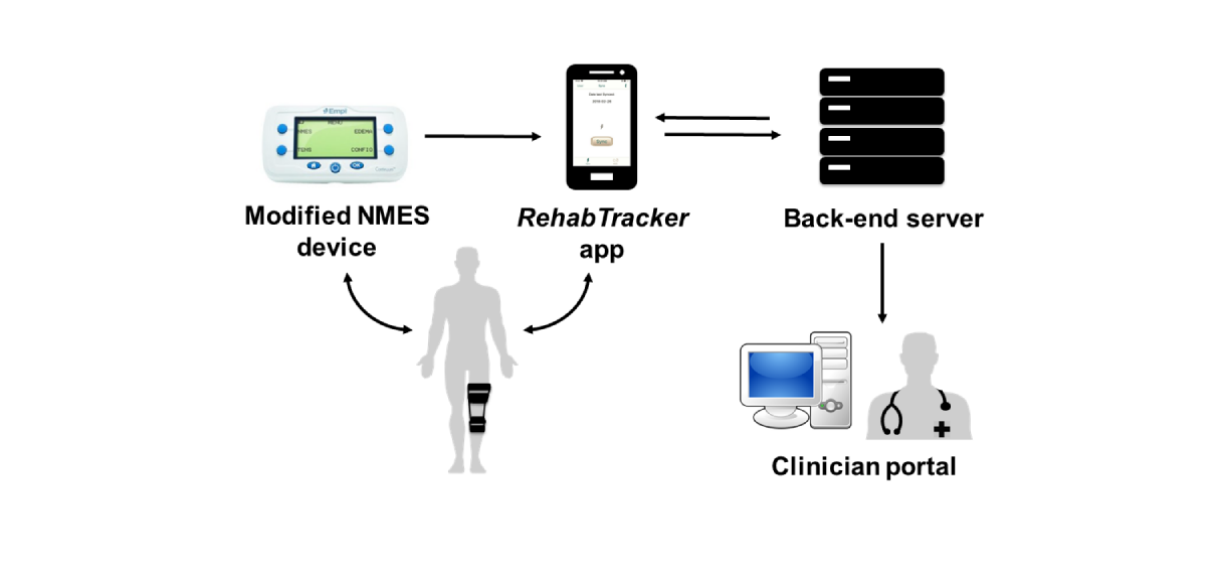
Figure 1. Simplified overview of the components of the RehabTracker cyber-physical system and user interactions. The RehabTracker mobile health (mHealth) app receives and transmits neuromuscular electrical stimulation (NMES) use data and serves as a conduit for patient-provider interactions. A secure, Health Insurance Portability and Accountability Act–compliant, back-end server receives the device use data, displays the adherence data for care provider review, and sends automated push notifications to the mHealth app, with the goal of improving adherence to the NMES prescription. NMES: neuromuscular electrical